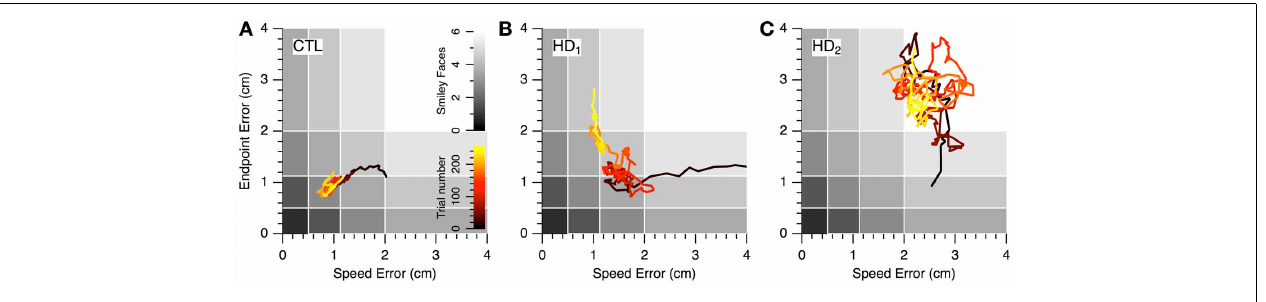
FIGURE 6 | Progression of speed-accuracy performance during practice. The progression of skill error in performance space is shown by plots of endpoint error vs. speed error (smoothed with 16-trial window moving